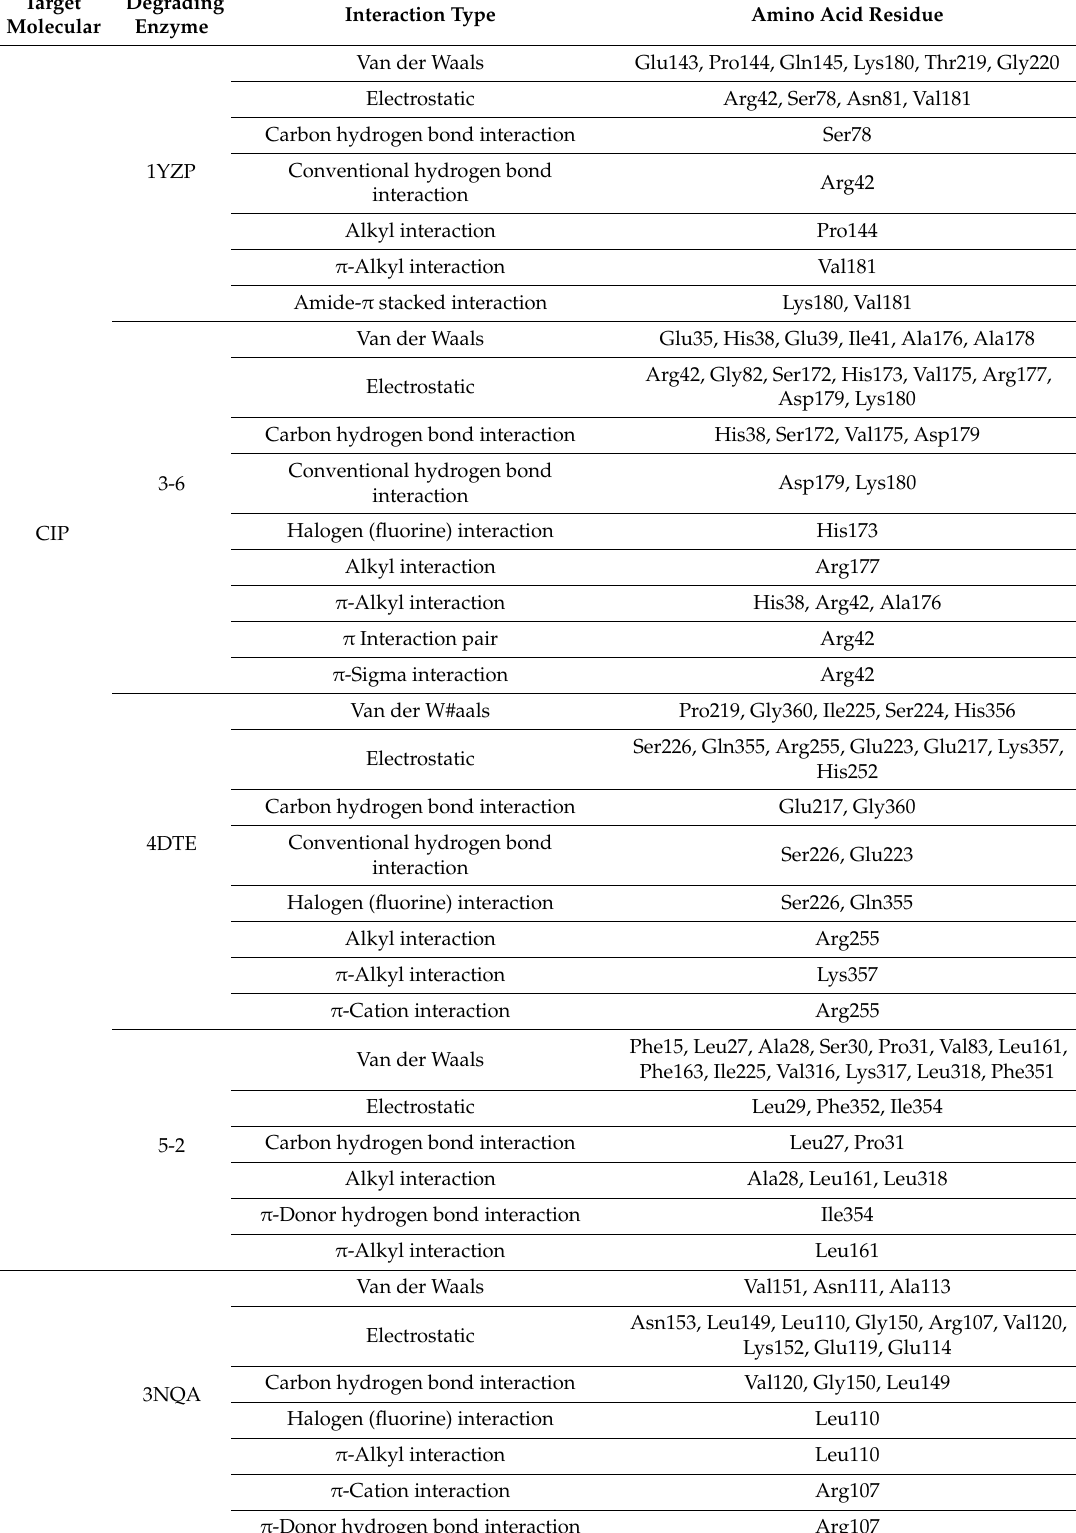
Table 7. Interaction between novel degrading enzymes and target